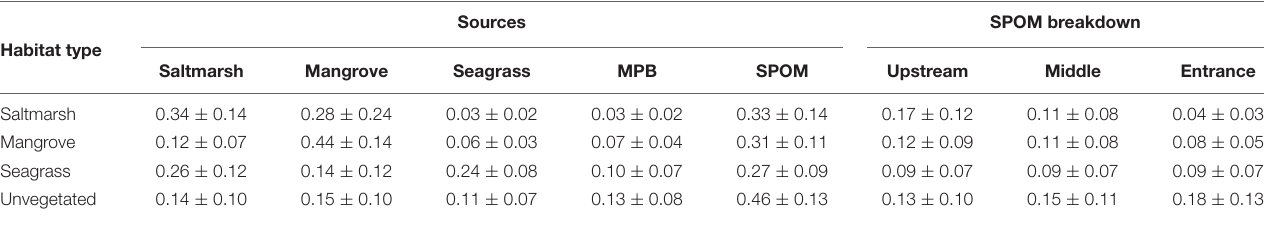
TABLE 2 | Proportional contributions of four potential sources to the sediment organic carbon within each habitat type based on SIMMR mixing model results (mean ± standard deviation).